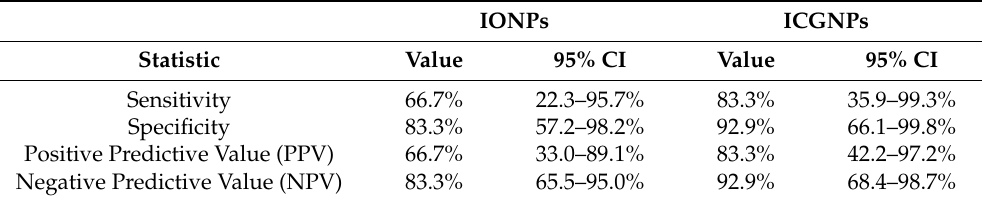
Table 2. Comparison between IONPs and ICGNPs methods on double-blind Salmonella